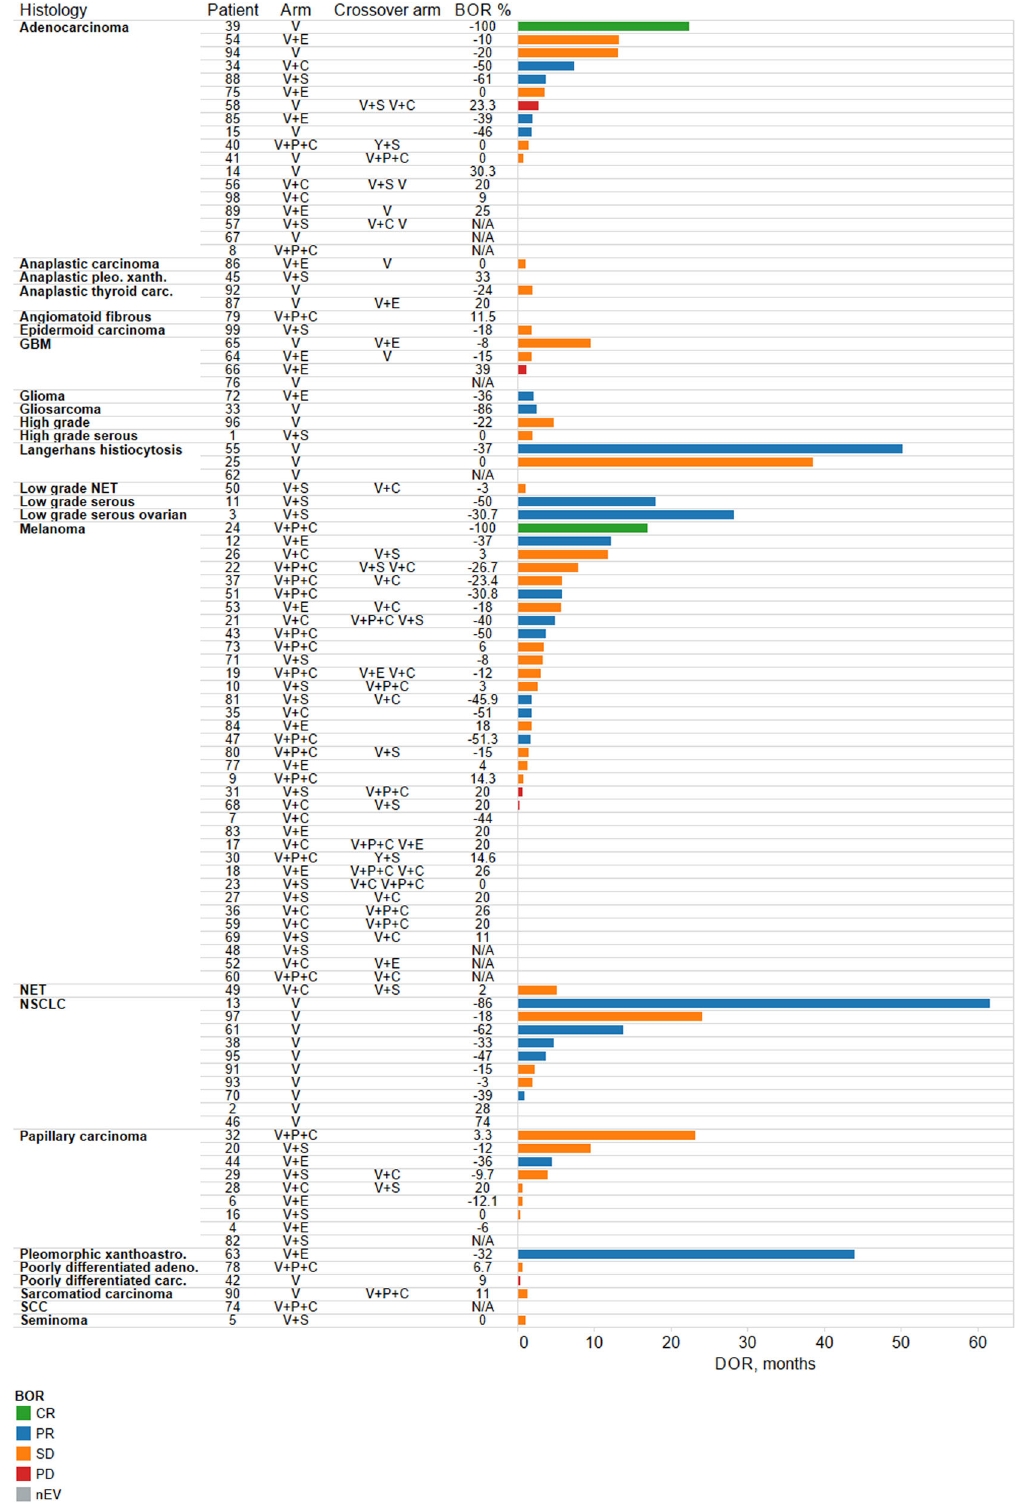
Fig. 6 Integrative genomic landscapes of various solid tumors with genomic alterations in the pooled analysis of four phase one clinical trial. Each horizontal lane describes a single gene, the vertical lines represent different samples, and different colors indicate mutation